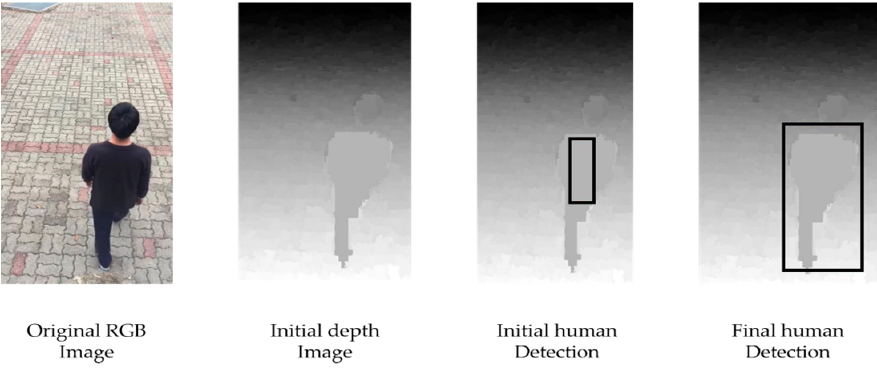
Figure 4. Human body detection process using a generated depth image.